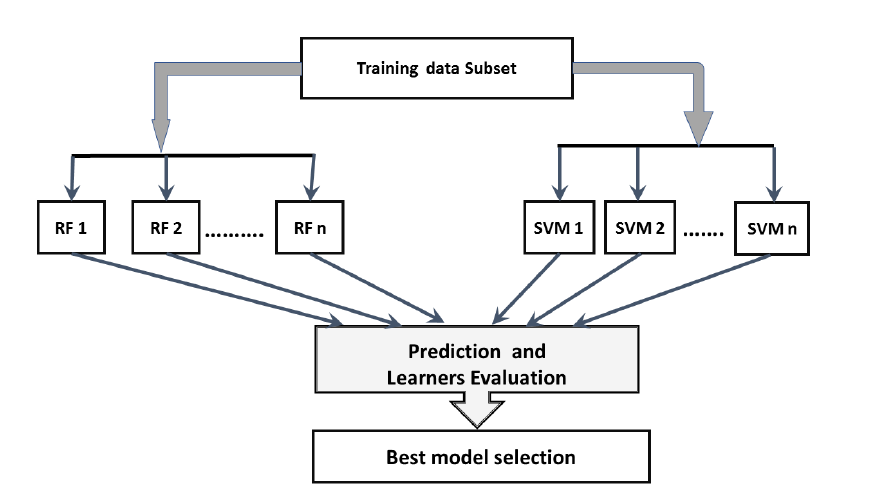
Figure 2. Proposed method in voting